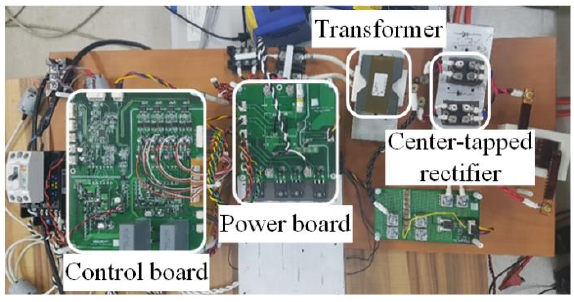
Figure 13. Experimental setup.